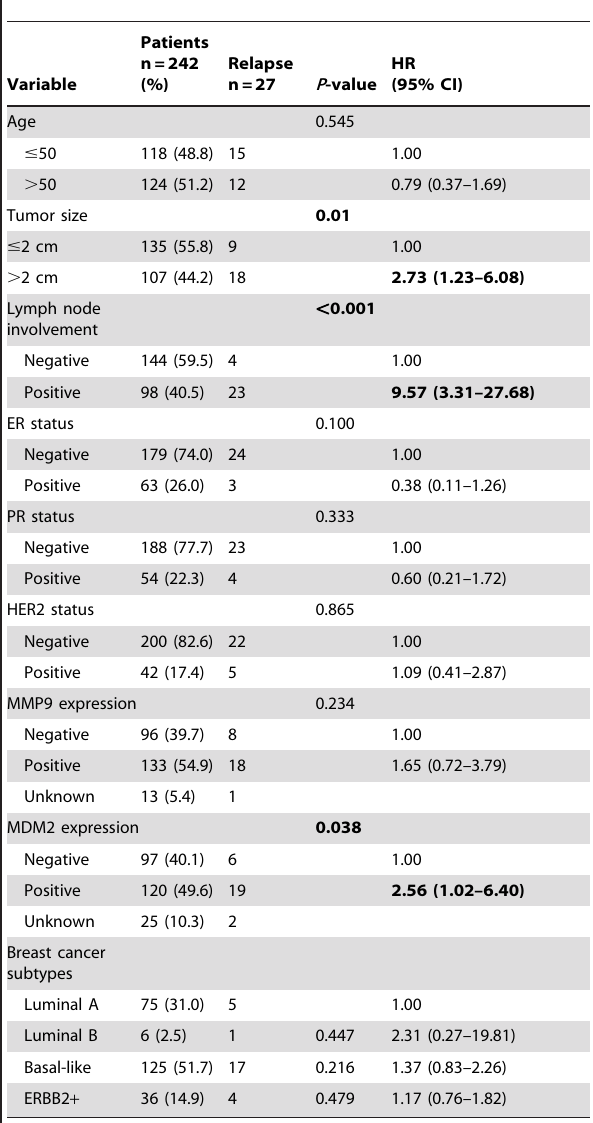
Table 2. Univariate analysis using Cox proportional risk modeling in patients with